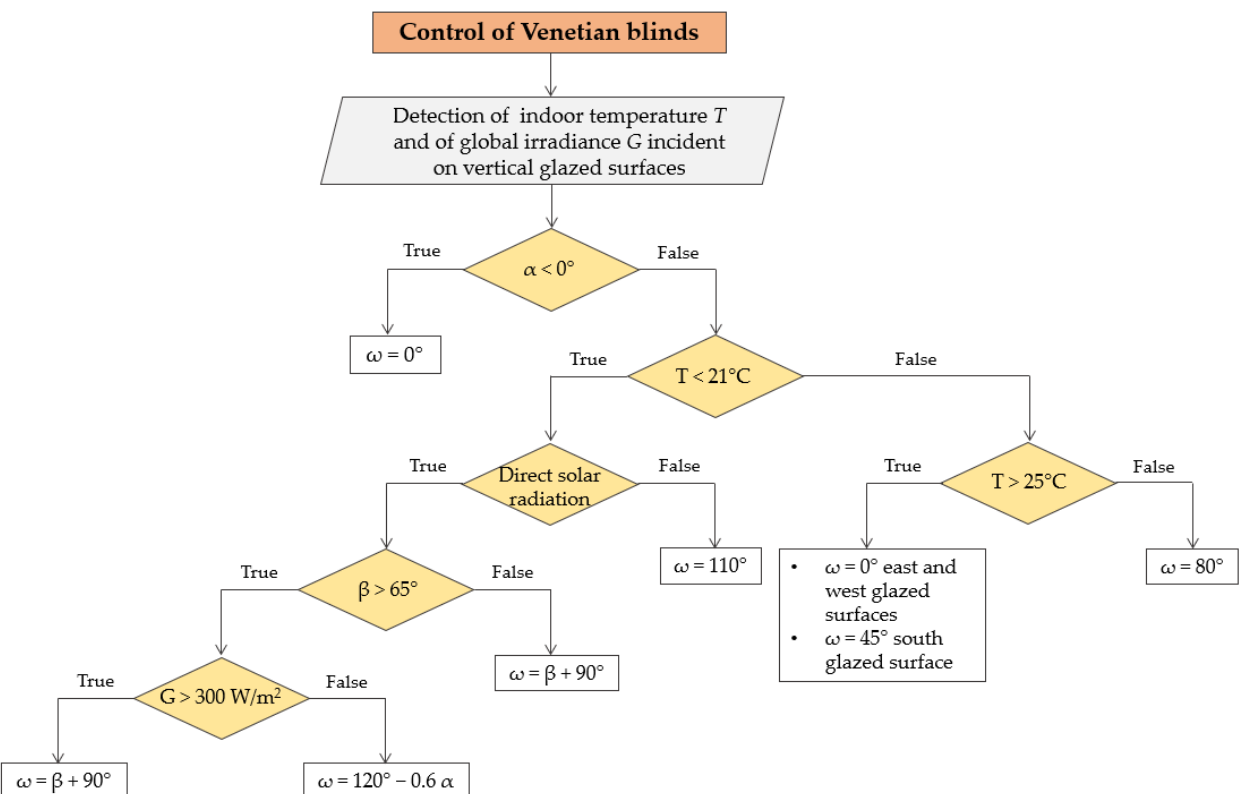
Figure 5. Control algorithm adopted for the regulation of SPBs.